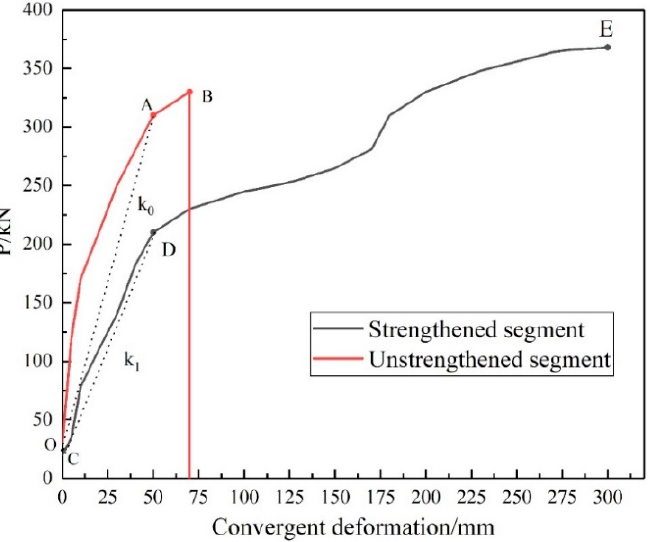
Figure 17. Load–convergence deformation of the strengthened and unstrengthened segments. Table 4. Performance comparison between the strengthened and unstrengthened segments.